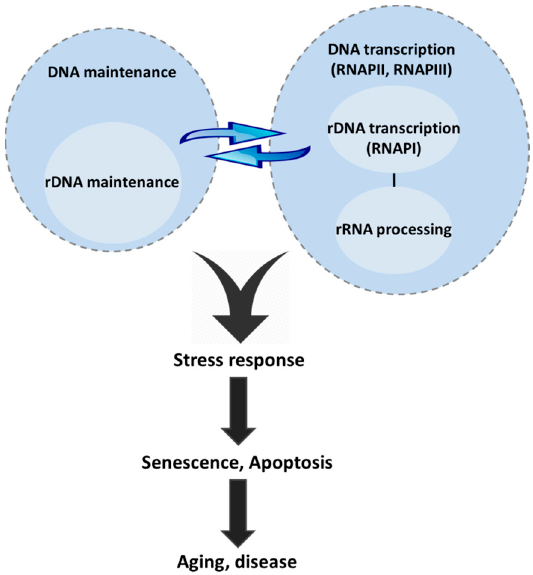
Figure 3. The crosstalk between the DNA and rDNA maintenance pathways and rRNA biogenesis regulates the stress response. DNA damage dramatically affects the nucleolar architecture and function through a network of interactions and translocations where rRNA biogenesis factors participate in DNA repair. Vice versa, DNA maintenance factors participate in and regulate rDNA transcription. In addition, nucleolar factors directly regulate the stress response. Genome maintenance pathways, nucleolar transcription and rRNA processing form a complex network that converges to the stress response, activation of which ultimately leads to aging and/or age-related disease or progeria, whereas evasion leads to cancer.